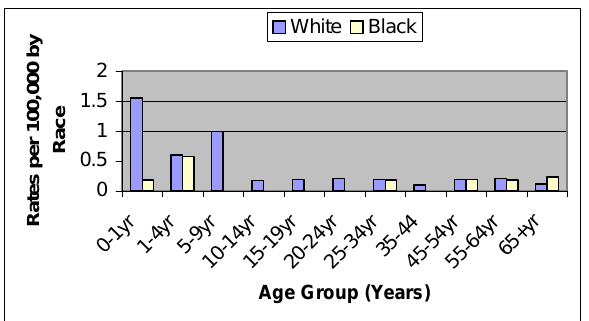
Figure 2: E.coli O157:H7 average incidence rates by race and age for the years 1996 - 2001 in Louisiana (LDHH 2001).